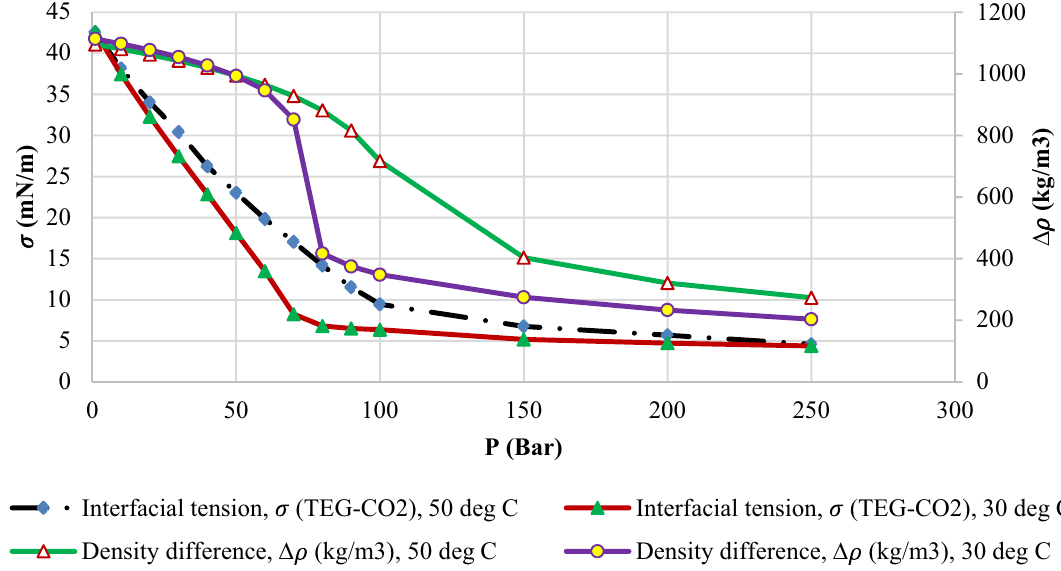
Fig. 5 Static interfacial tension of tri-ethylene glycol (TEG) in CO sity difference of TEG–CO 2